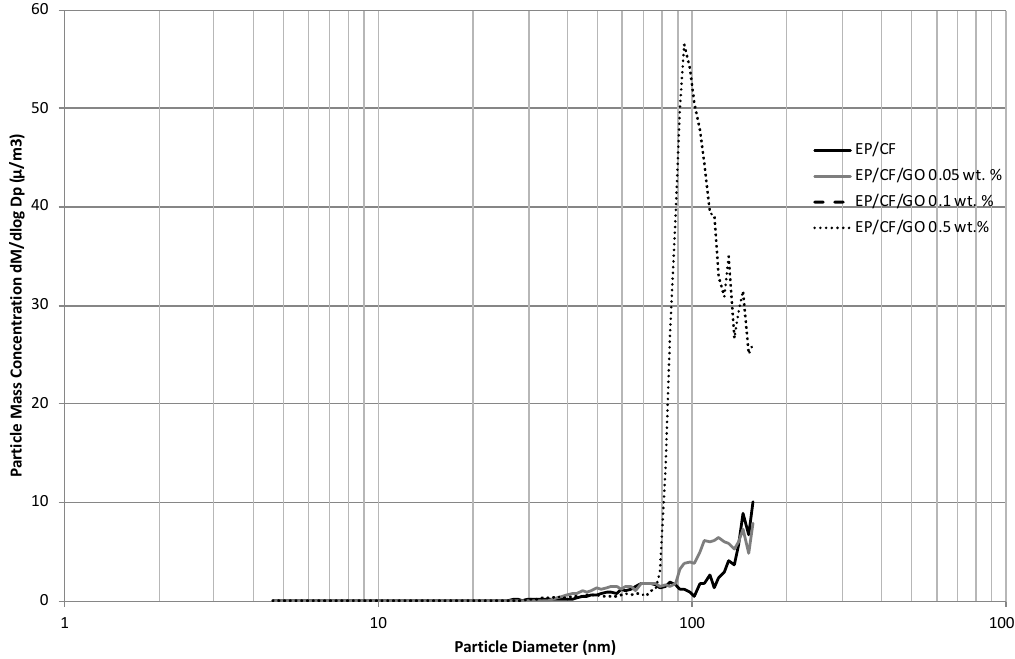
Figure 8. Particle mass concentration average over 4 min of EP / CF based nanocomposites reinforced with GO determined from SMPS ( n = 12 for each average).